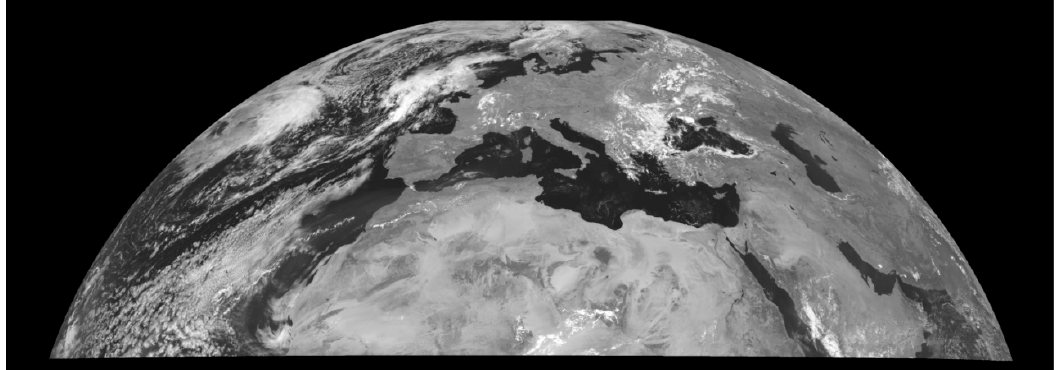
Figure 1. Infrared image from the Rapid Scanning Service (RSS).